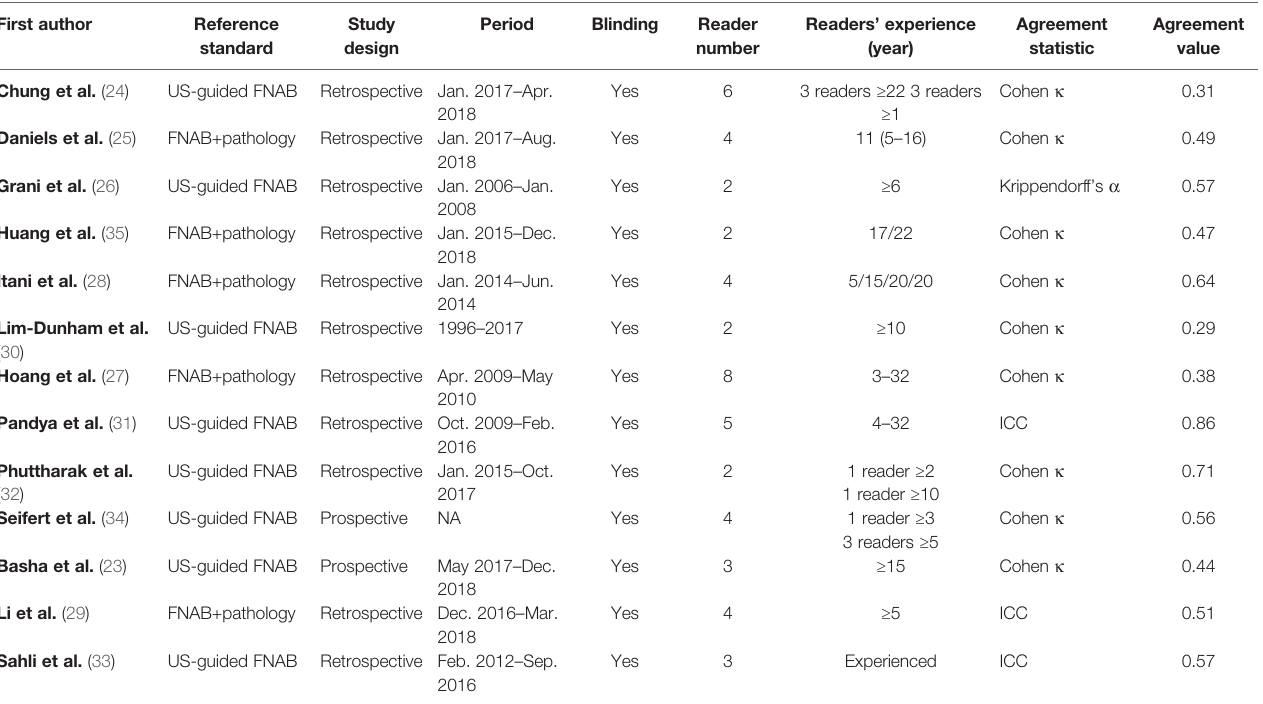
TABLE 2 | Study characteristics of included studies.